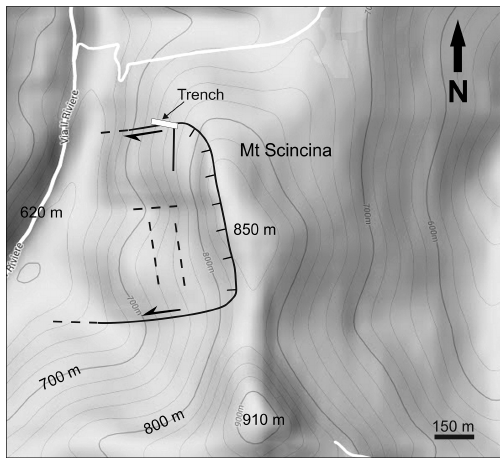
Figure 2. Digital elevation model of the area of the deep-seated gravitational slope deformation (DSGSD) at Mt Scincina (western Alps, Italy), with location of the trench studied by way of palaeo- seismological techniques, and trace of the main morphostructures indentified at the